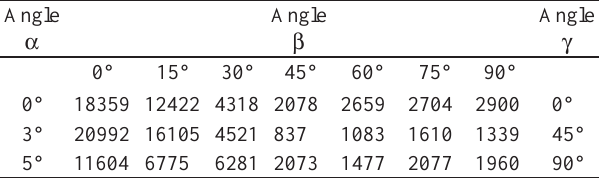
Table 5. Experimental and Theoretical Data of Jatobá (in MPa).